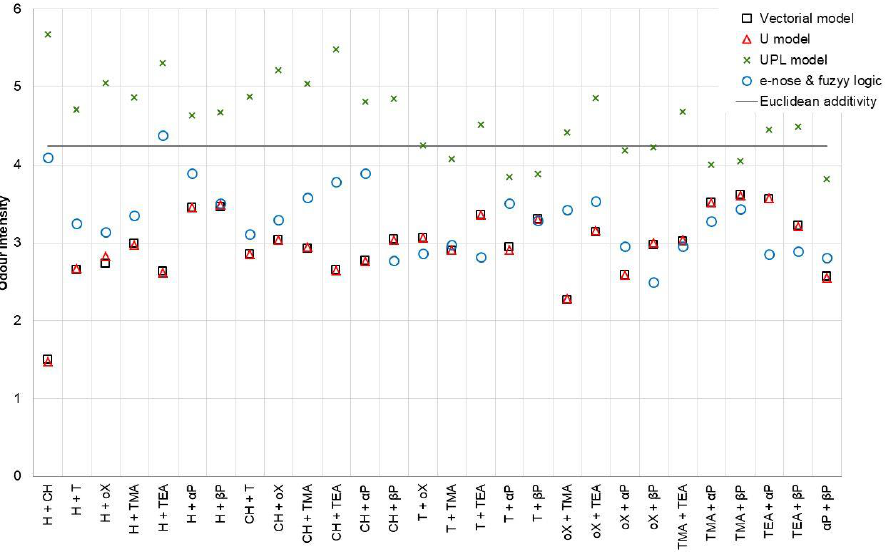
Figure 7. Odor intensity prediction models comparison (H — n -hexane, CH — cyclohexane, T — toluene, oX — o -xylene, TMA — trimethylamine, TEA —triethylamine, αP—α - pinene, βP—β -pinene).